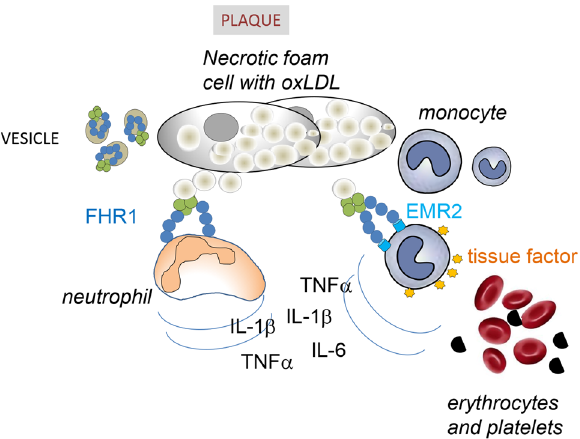
Figure 6. Model of FHR-1-induced inflammation. Extracellular vesicles that transport FHR-1 (EV FHR1 ) bind to oxLDL in necrotic cores of atherosclerotic plaques and activate neutrophils and monocytes. These monocytes and neutrophils release inflammatory cytokines, which attract more immune cells. FHR-1 also induces monocytes to express tissue factor on their surfaces, which can trigger the coagulation pathway and thrombosis, the ultimate complication of